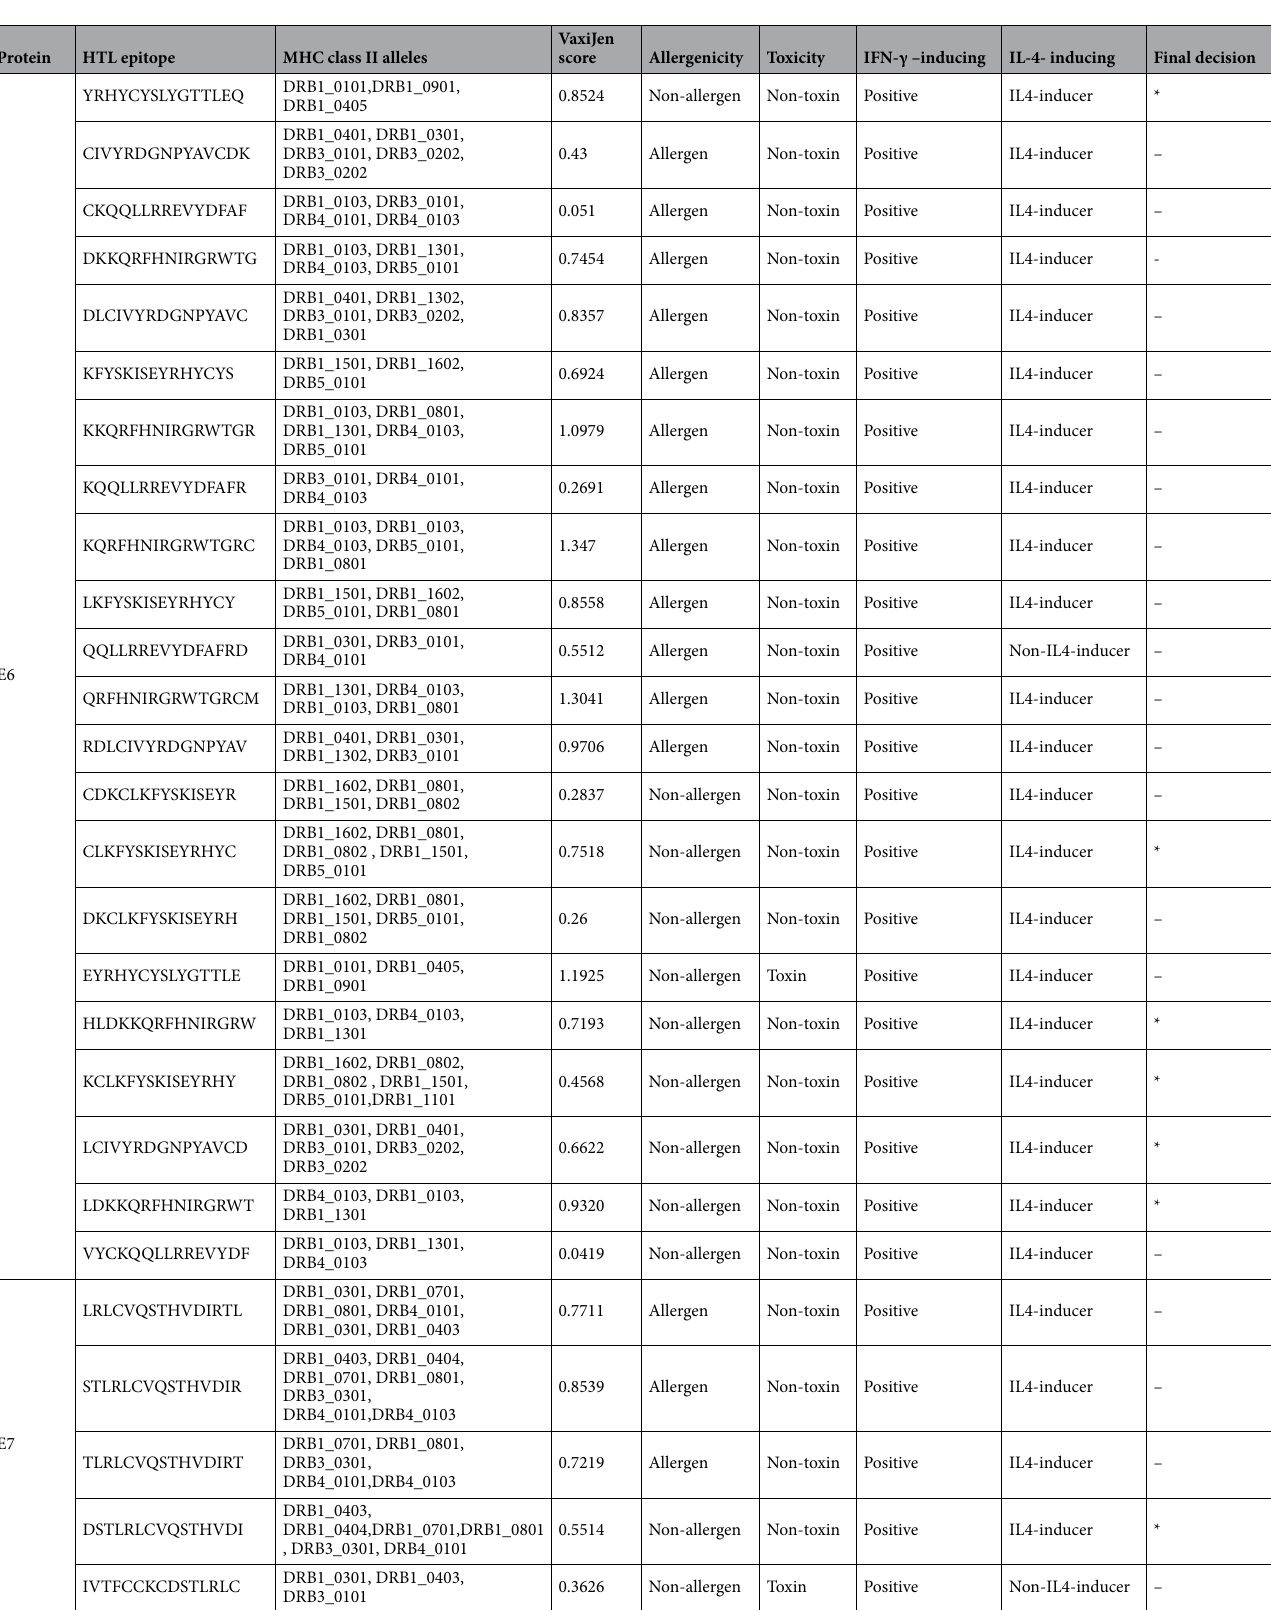
Table 2. Predicted HTL epitopes of E6 and E7